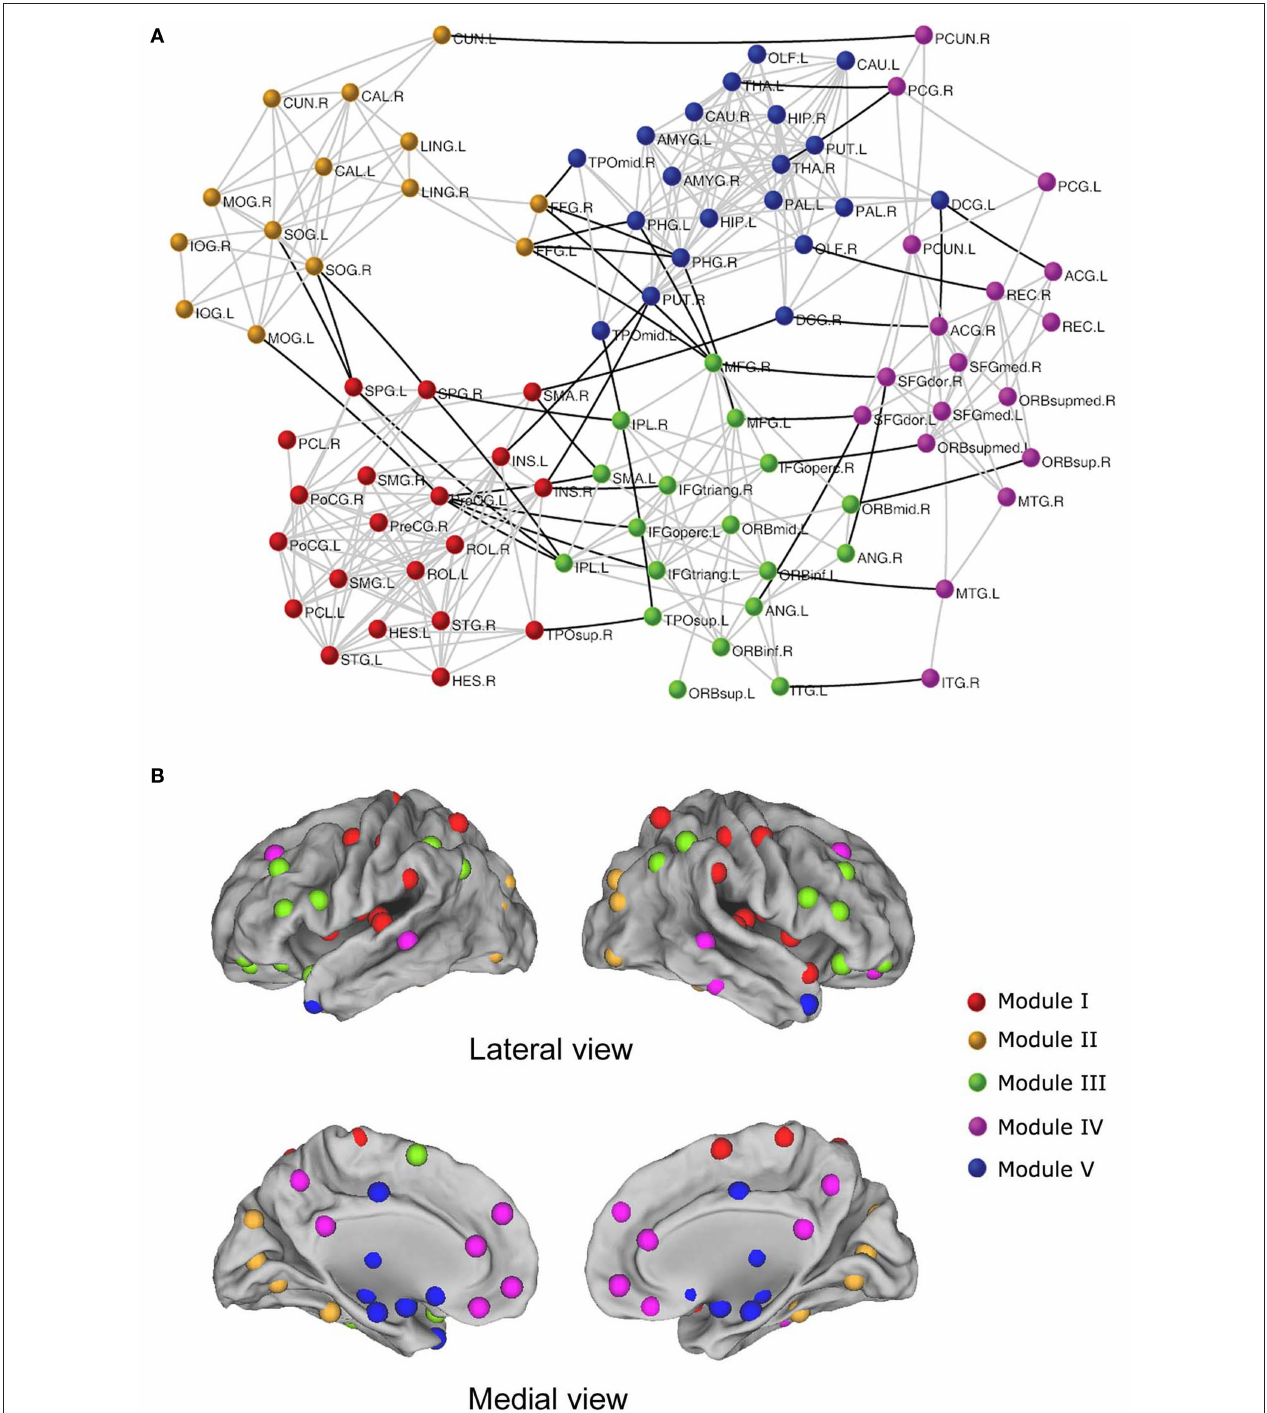
FIguRe 2 | The modular architecture of resting-state functional brain network (He et al., 2009b ). (A) Five modules were identified in a functional network of the human brain, represented by five different colors. The geometric distance between brain regions on the drawing space approximates the shortest path length between them. The network is visualized with Pajek (http://vlado.fmf. uni-lj.si/pub/networks/pajek/). The intra-module and inter-module connections are shown in gray and dark lines, respectively. For the abbreviations of the regions,